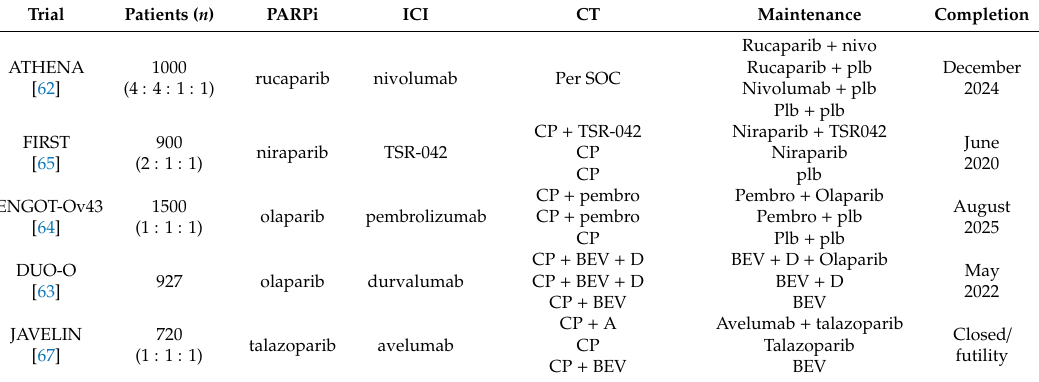
Table 2. Phase III frontline trials associating Immune Checkpoint inhibitor (ICI) and PARP inhibitors ±